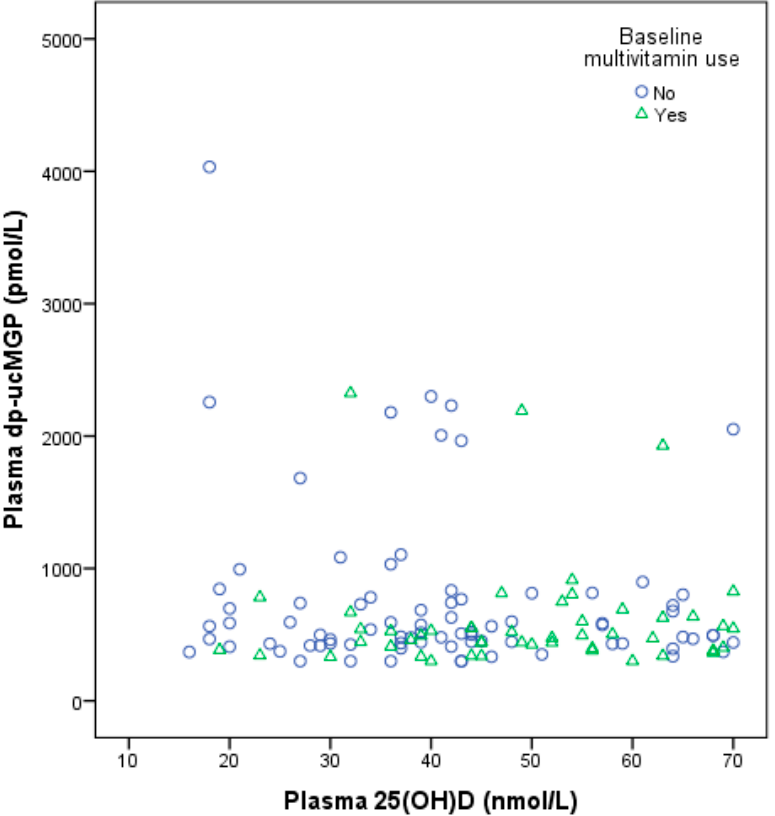
Figure 2. Baseline scatter plot of plasma 25-hydroxvitamin D and plasma dp-ucMGP concentrations by multivitamin use. Rounds: No multivitamin, n = 81; triangles: Multivitamin use, n = 50.